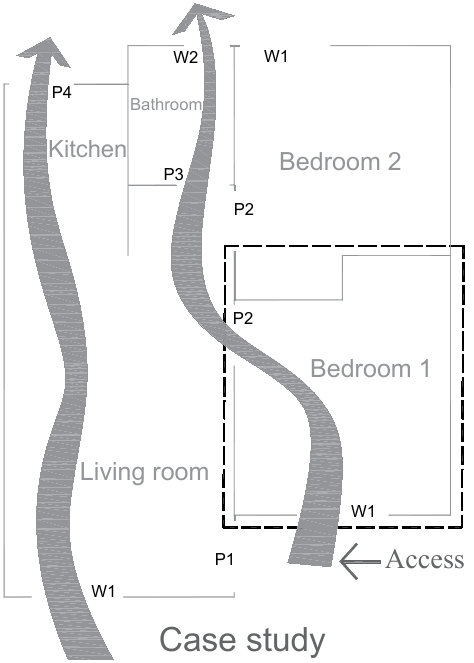
Fig. 2. Distribution and representative space in the benchmark